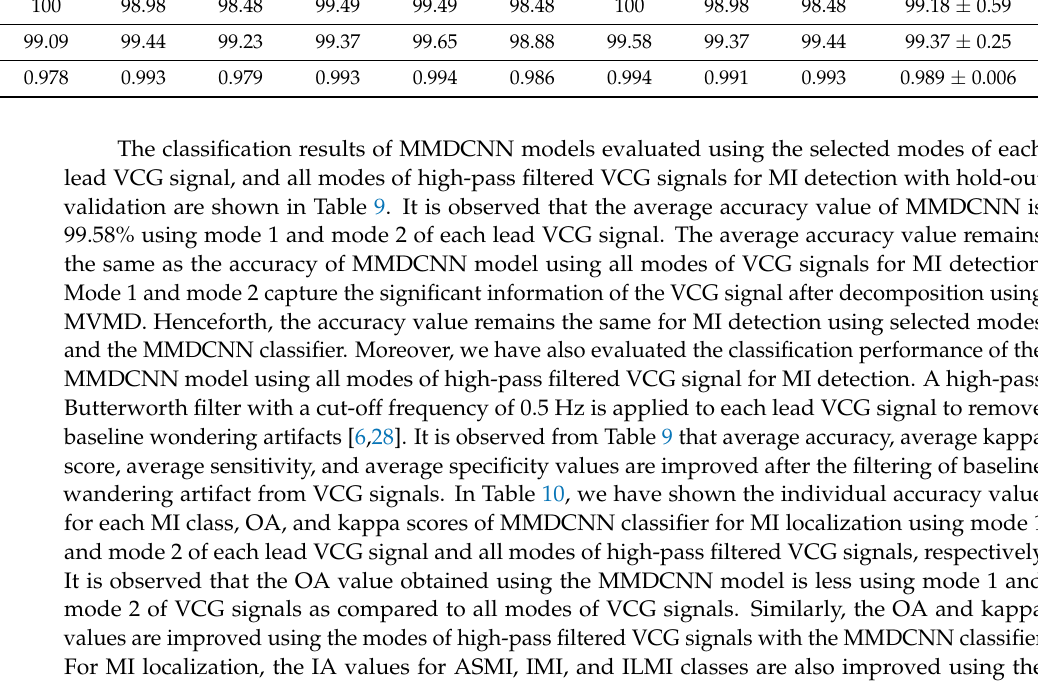
Table 8. Classification results obtained for MI localization using proposed MMDCNN model with 10-fold CV. Folds